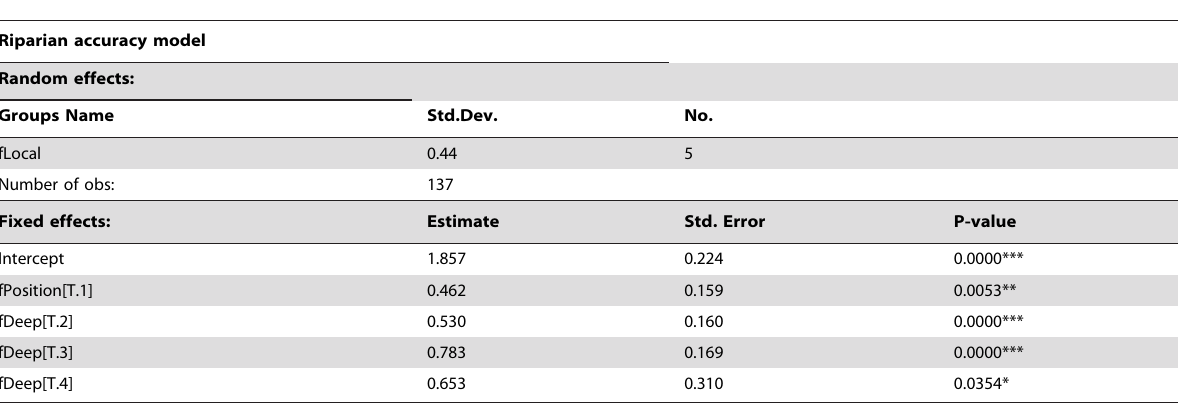
Table 5. Results of the Riparian GLMM model to predict GPS Location Error.